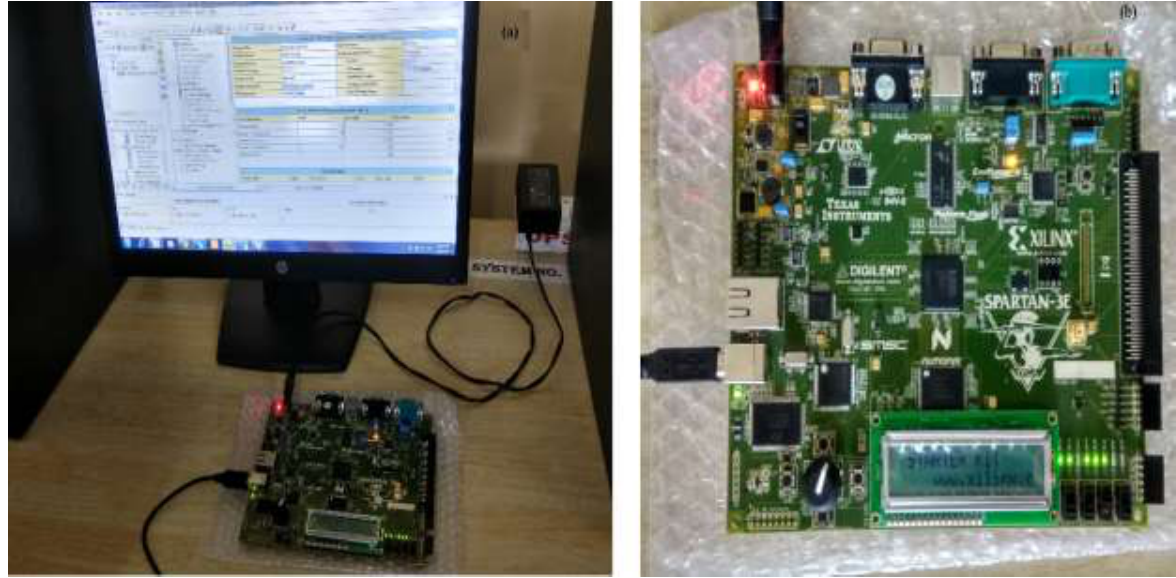
Figure 7 Experiment verification on SPARTAN-3E